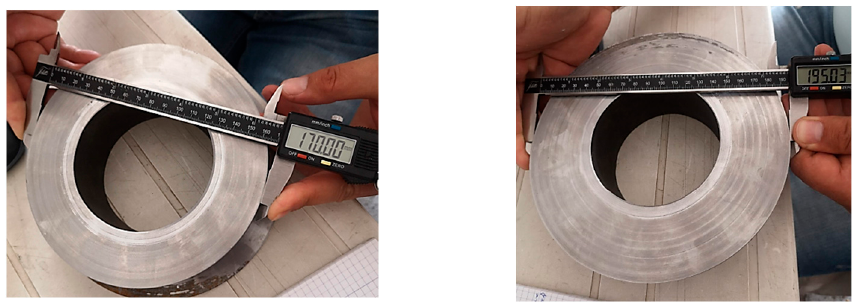
Figure 13. Dimensional control of the external diameters obtained after machining.